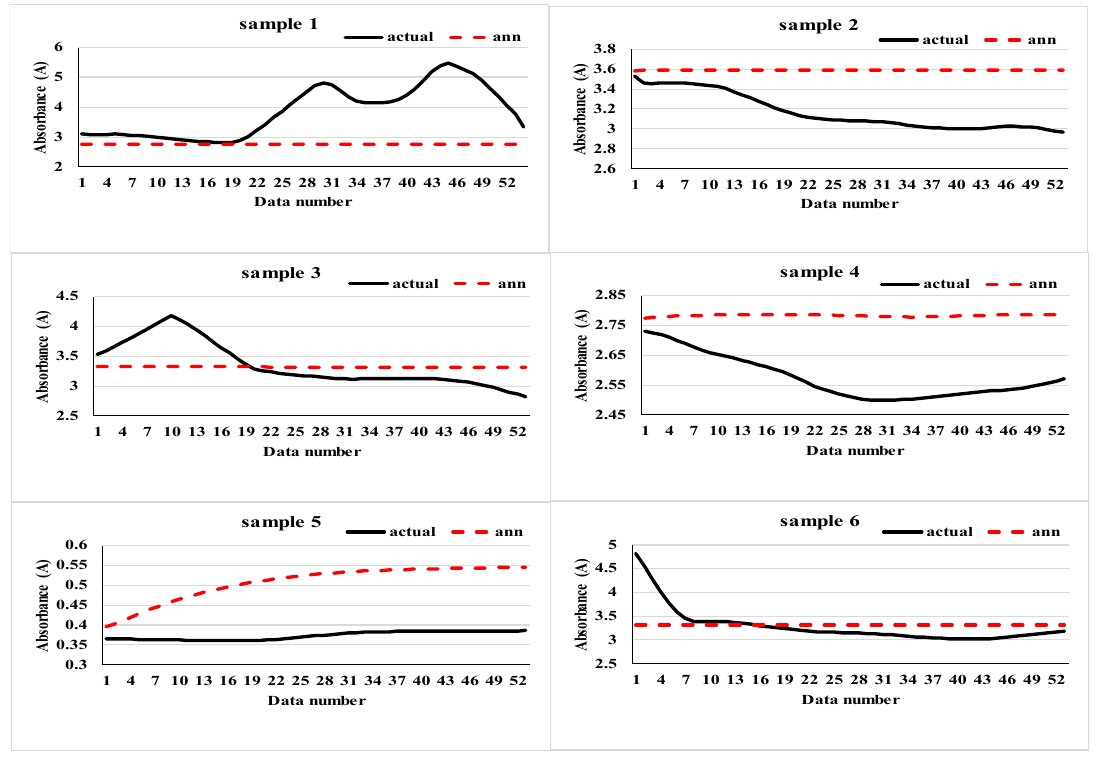
Figure 9. Validation of experimental UV–vis data with ANN.